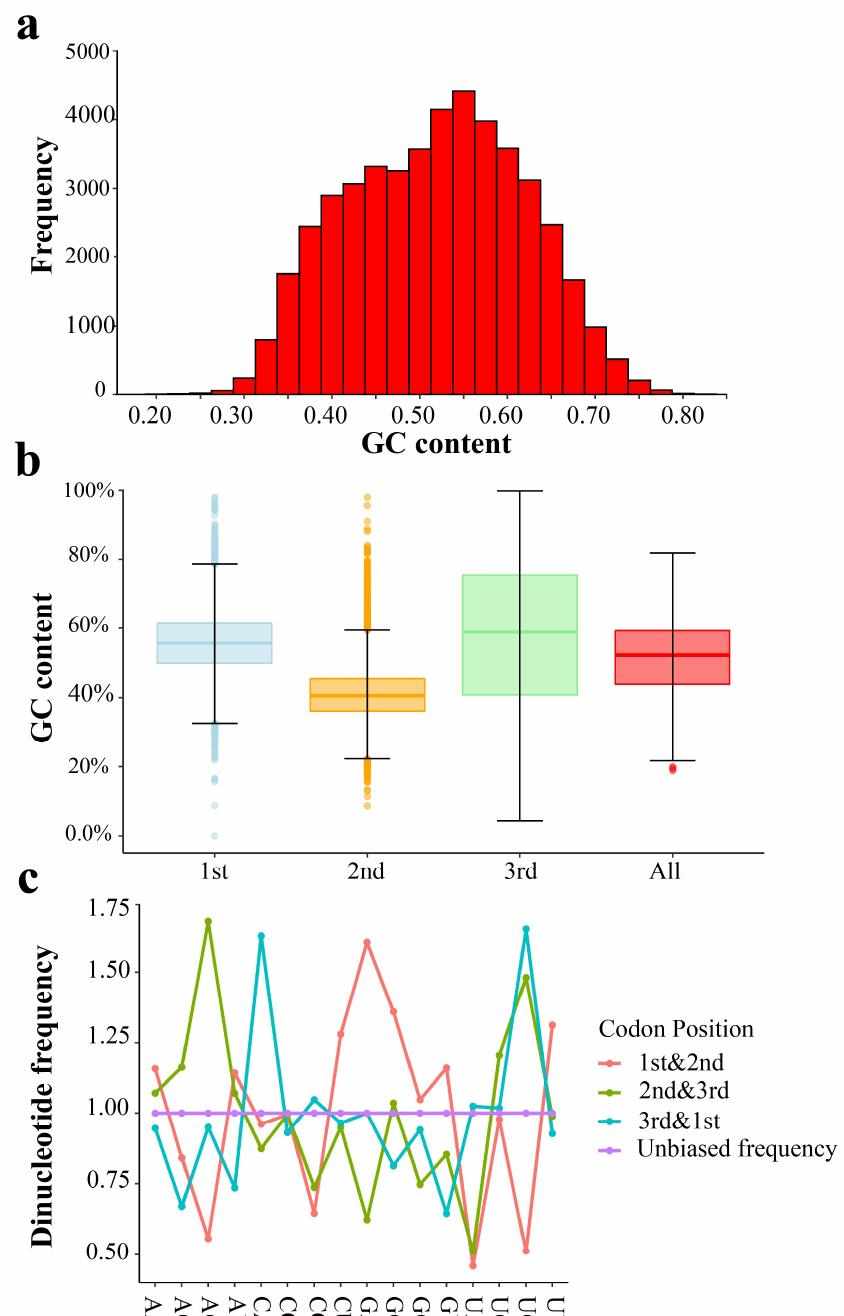
Figure 1. Base composition of the assembled transcriptomic data. ( a ) Distribution of GC content levels among coding sequences (CDS). ( b ) Box plot showing GC content variation among different codon positions and the genome average (All). ( c ) Dinucleotide frequencies at different codon position combinations (1st and 2nd, 2nd and 3rd and 3rd and 1st). The straight line represents the theoretical equal frequency (1/16).